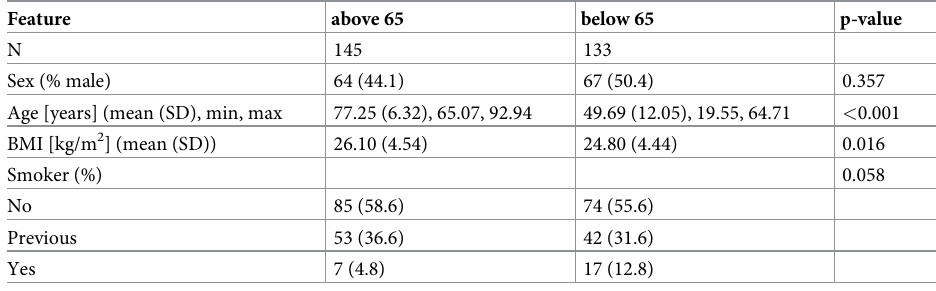
Table 1. Characterization of the study cohort.